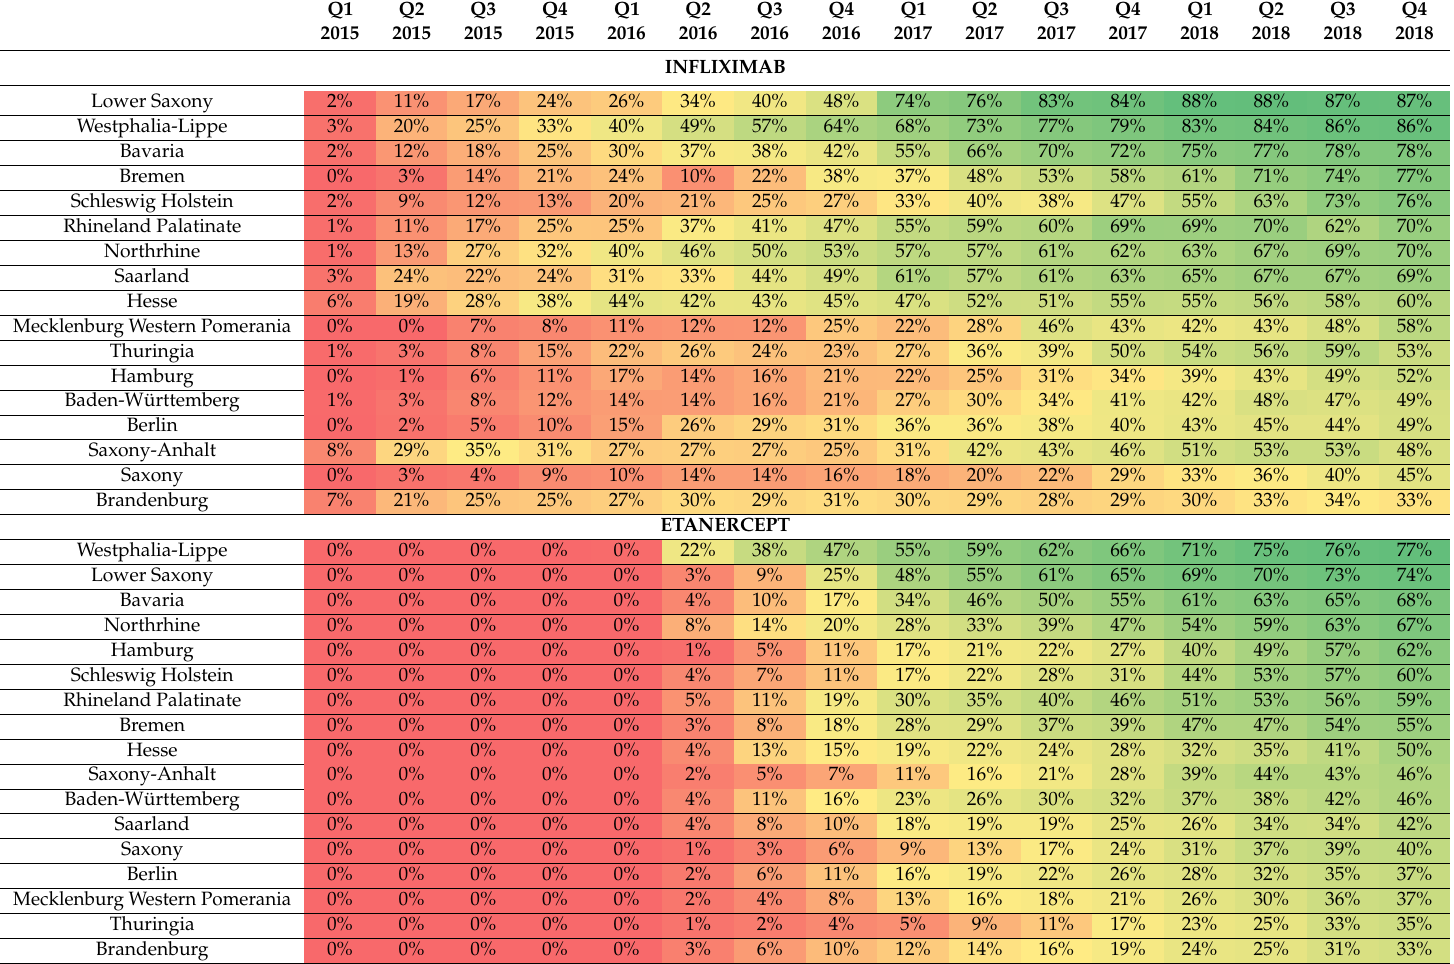
Table 1. Market shares (%) of biosimilar infliximab and etanercept in Germany’s 17 PA regions. Colors gradually change from red to green with increasing biosimilar market